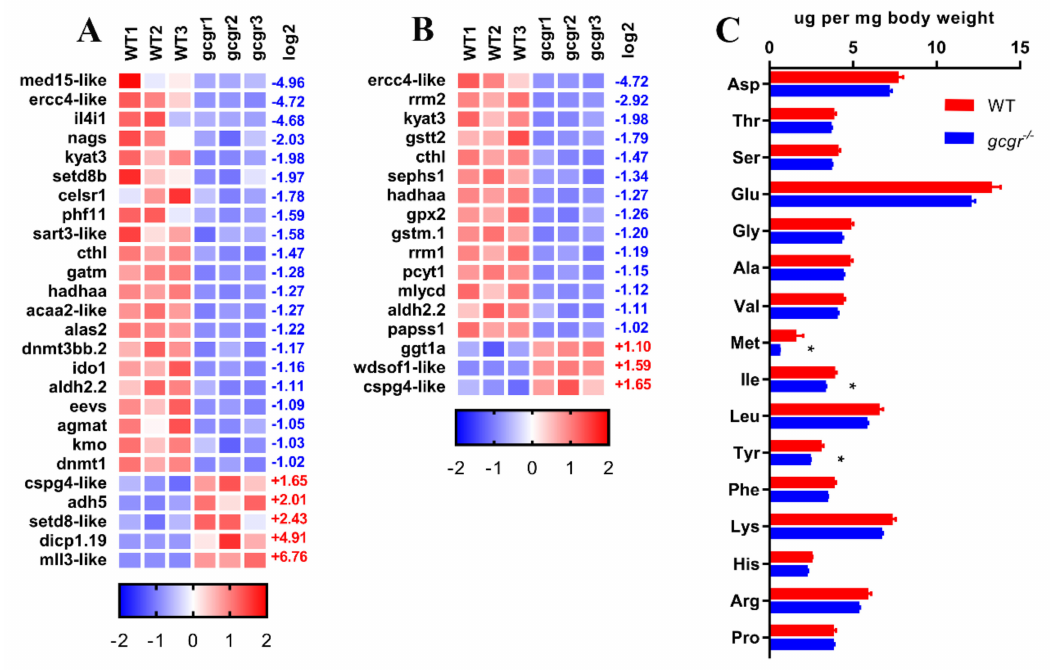
Figure 6. GCGR regulates amino acid metabolism in zebrafish larvae. ( A ) Heatmaps of transcripts in amino acid metabolism enrichment. ( B ) Heatmaps of transcripts in metabolism of other amino acid enrichment. ( C ) Amino acids compositions in WT and gcgr − / − embryos. Results were represented as means with standard errors ( n = 3), * p < 0.05 by t